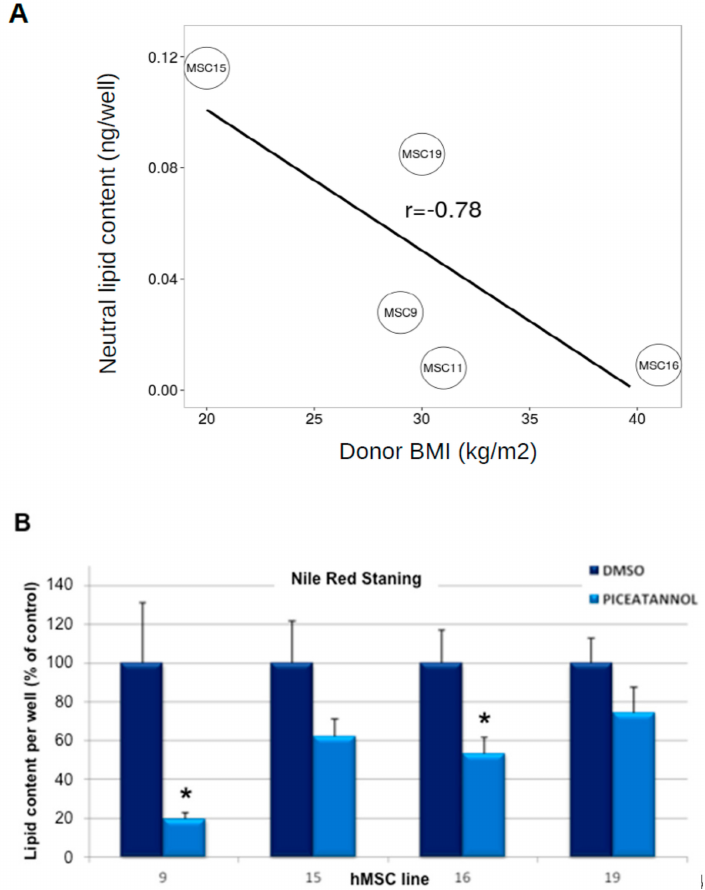
Figure 3. Influence of piceatannol on lipid accumulation in hMSC-derived adipocytes. hMSC obtained from five individuals anonymously renamed MSC 9, 11, 15, 16, and 19 were differentiated into adipocytes. ( A ) Relationship between body mass index of donor and lipid accumulation per well. Each point on the Y-axis is the mean of quadruplicates. Significant coefficient of linear regression is indicated. ( B ) Effect of 50 µ M piceatannol on lipid accumulation in four hMSC lines expressed as percentage of optimal adipogenic condition in the presence of vehicle (DMSO, dark columns). Each percentage is the mean ± SEM of eight replicates. Different from vehicle at * p < 0.05 by Student’s t